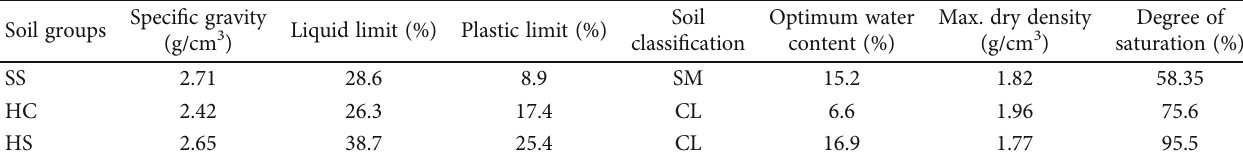
Figure 1: View of a high-salinity soil sampling site along the Qarhan-Golmud Highway. Photo taken in April 2021. Table 1: Physical property parameters of the test soil sample.